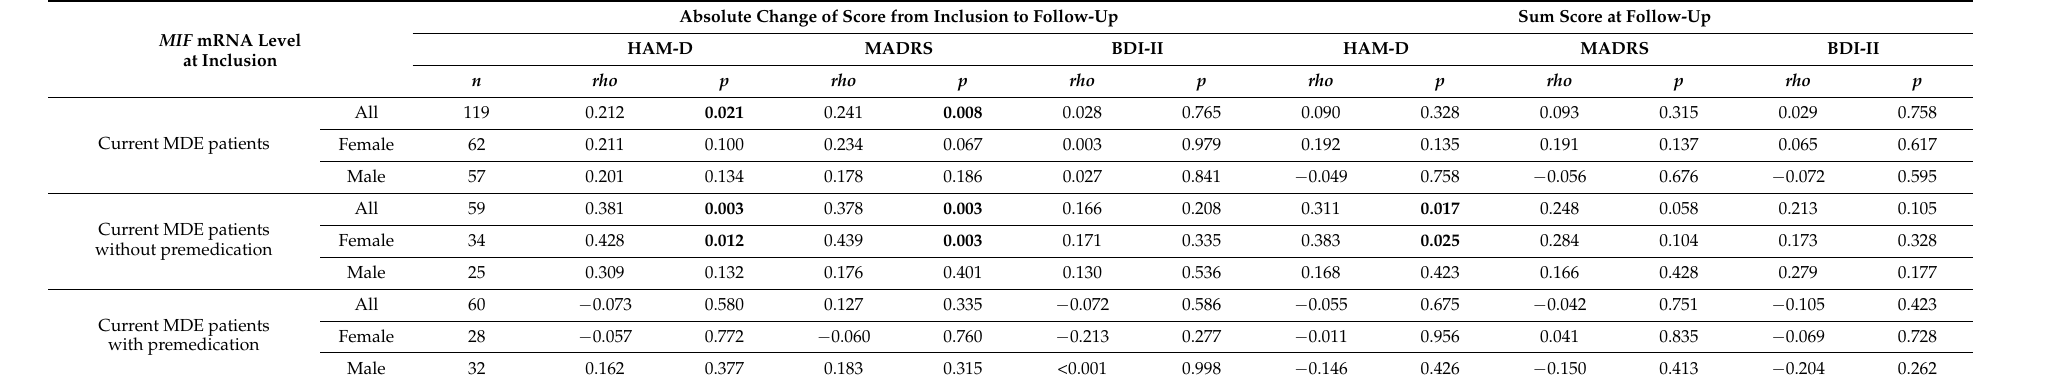
Table 4. MIF expression level at inclusion predicts absolute change of depression severity and score at follow-up as assessed by rating by a clinician (HAM-D and MADRS) or self-rating (BDI-II) in patients with a current